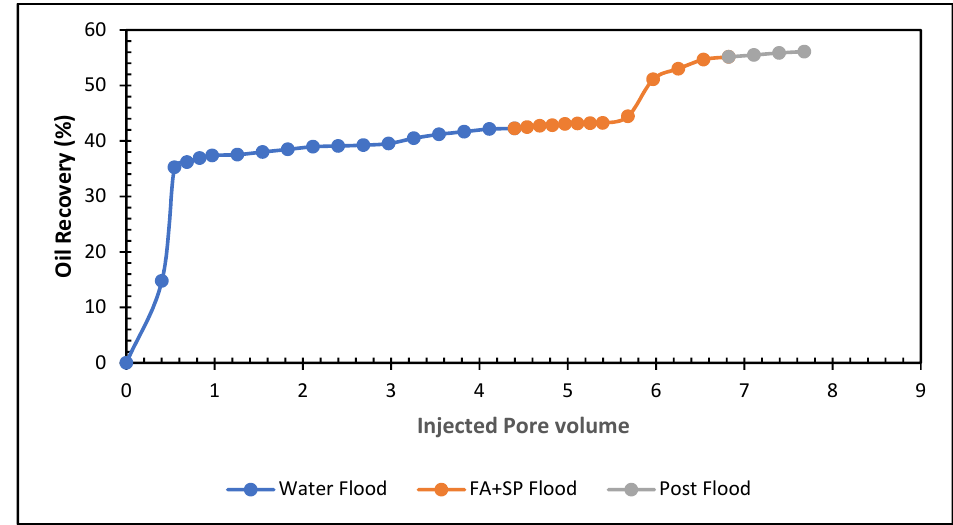
Figure 19. Total oil production from the carbonate core after brine, 0.5% formic acid, and SP mixture, followed by a post-flood with brine.